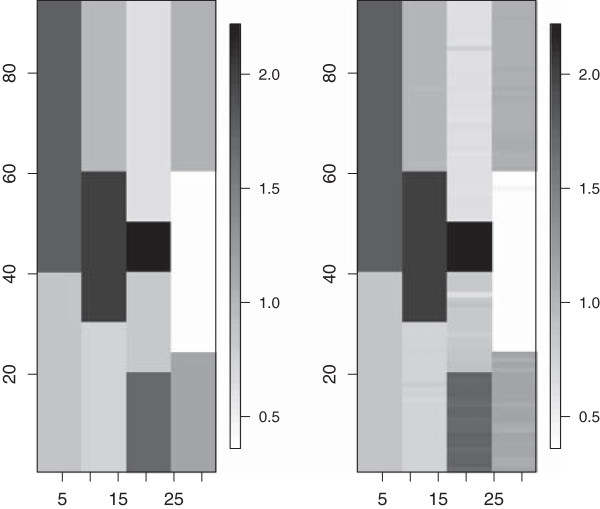
Image plots for true βi,jvalues (left panel) and posterior means β^i,js (right panel).